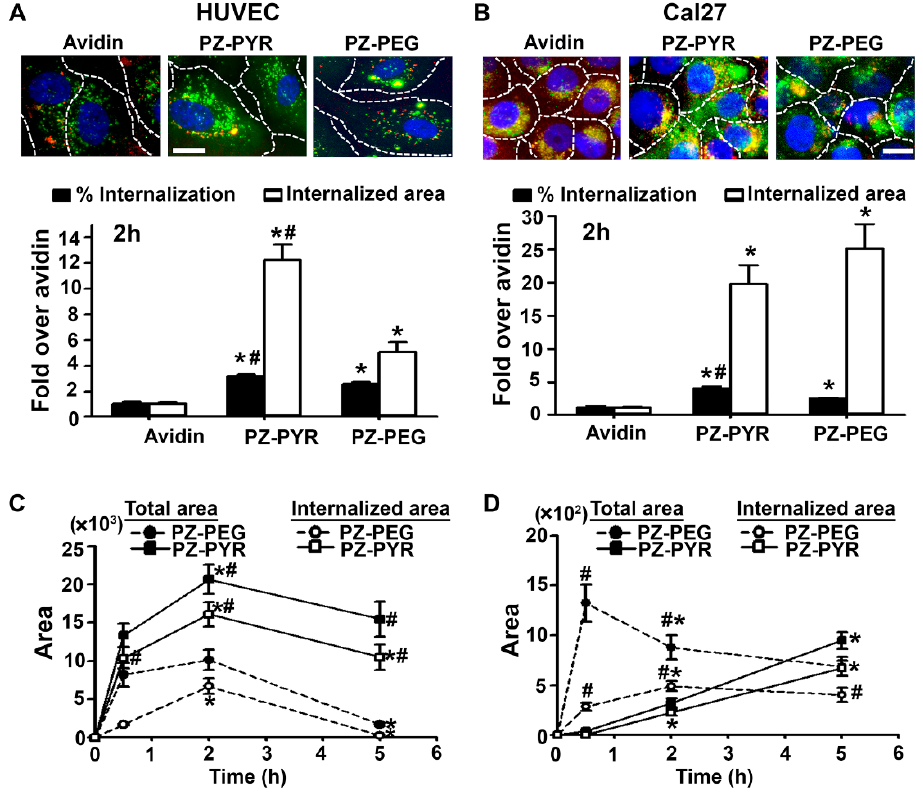
Figure 3. Uptake of PZ/protein complexes in different cell types. ( A ) HUVECs or ( B ) Cal27 cells incubated for 30 min at 37 °C with green FITC-avidin alone or complexed to PZ-PYR or PZ-PEG. Cells were washed, fixed, and incubated with Texas Red-labeled biotin-IgG to co-stain avidin on the cell surface in red (green + red = yellow) vs. internalized avidin (green alone). Blue = cell nuclei stained with DAPI. Dashed lines = cell borders as seen by bright field. Scale bar = 10 µm. Data are mean ± SEM. * p < 0.05 relative to avidin. ( C , D ) Similar experiments comparing different incubation times in ( C ) HUVECs or ( D ) Cal27 cells. Data are mean ± SEM. # p < 0.05 comparing both polymers, * p < 0.05 relative to the previous time point.